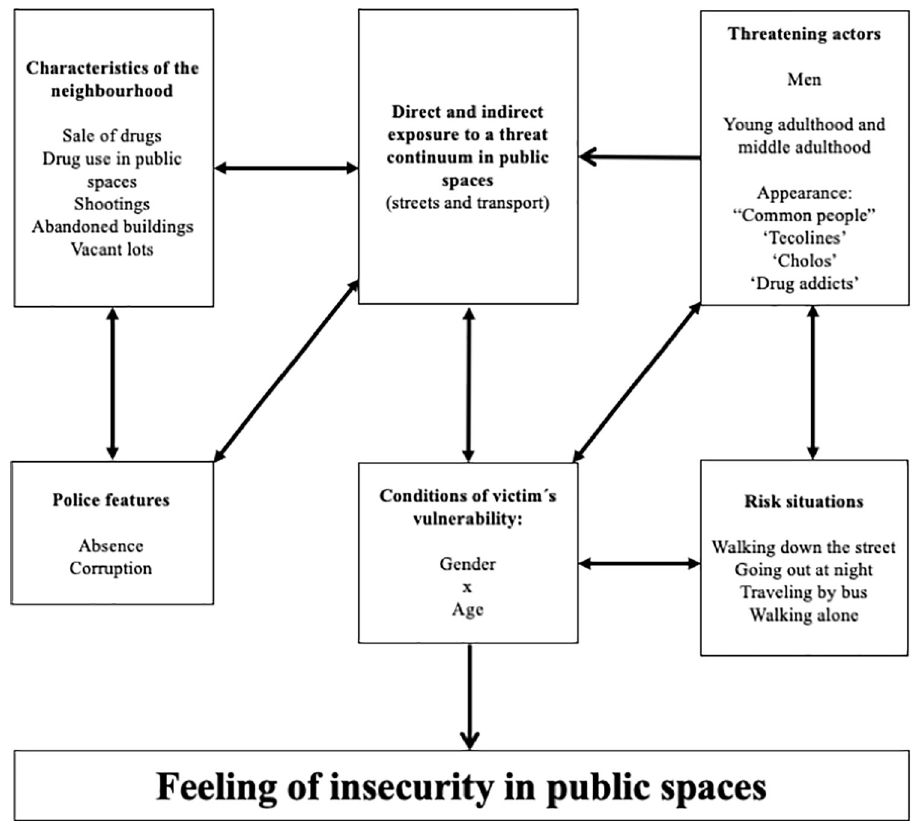
Fig 2. Contextual conditions of the feeling of insecurity in public spaces among young women. Source: Own